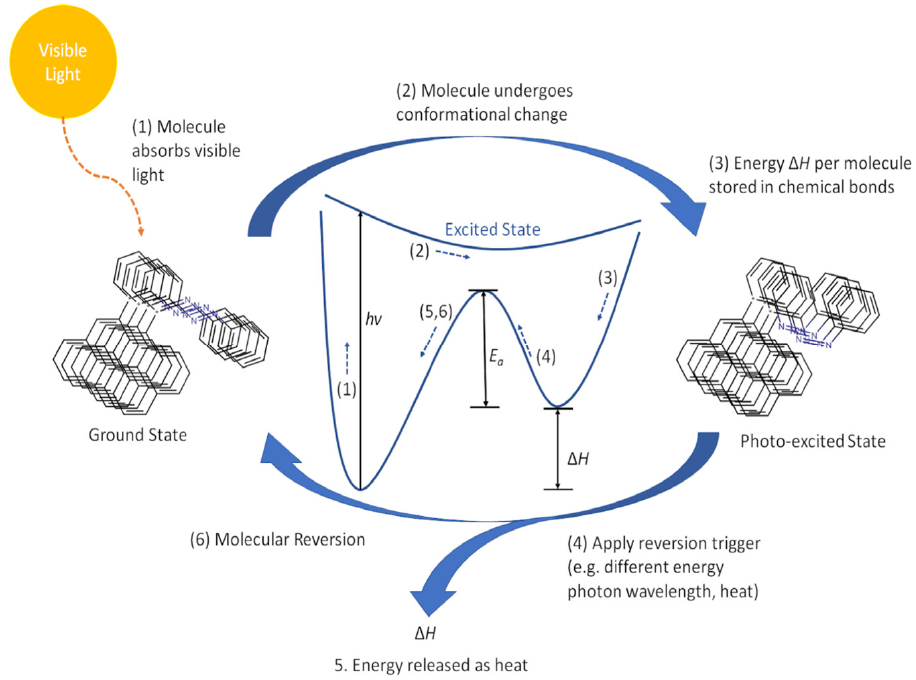
Figure 29. The principle of solar thermal fuels using azobenzene moieties functionalized with CNTs [121].